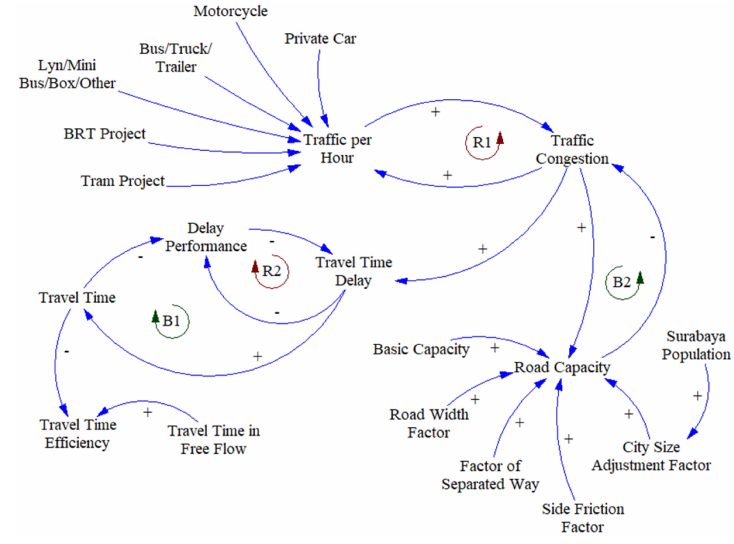
Fig. 1 Causal loop diagram of transport system on Urip Sumoharjo Street, Surabaya